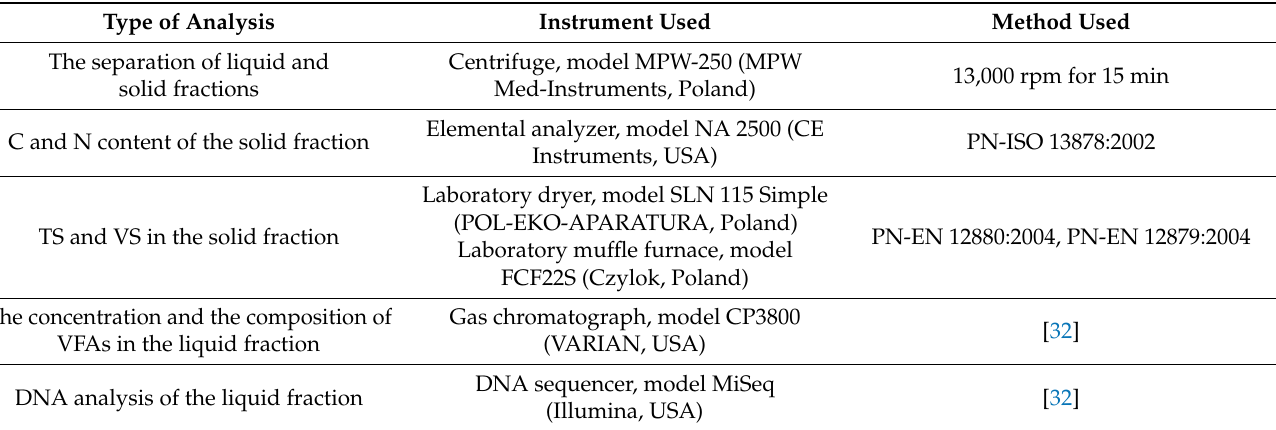
Table 4. Types of analysis which undergo liquid and solid fractions of the fermentation mixture, together with instruments and methodology